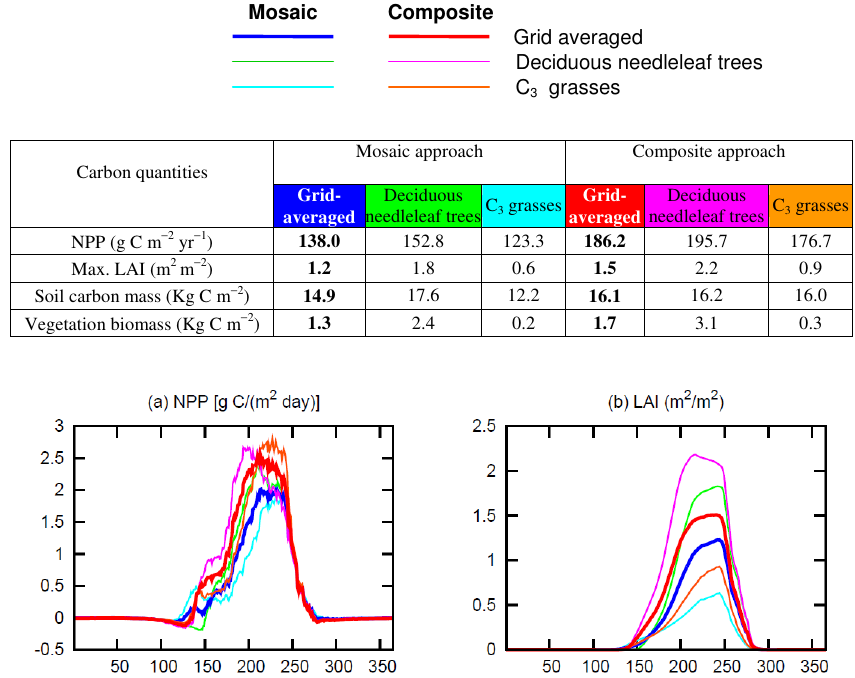
Fig. 5. Simulated daily averaged values of (a) NPP and (b) LAI for the Siberia location for individual PFTs and grid-averaged values when using the two approaches. The table at the top summarizes the average annual values of NPP, vegetation biomass, soil carbon mass, and annual maximum values of LAI when using the two